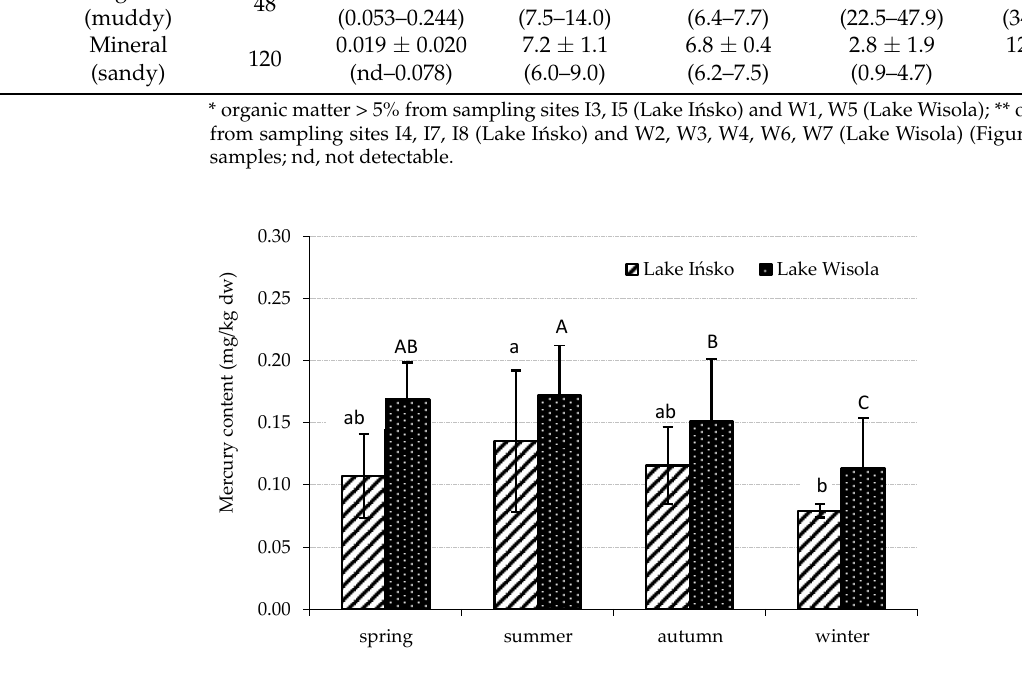
Figure 2. Seasonal variability in mercury content in organic sediments of lakes I ń sko and Wisola. Statistically significant seasonal differences in the content of Hg in the sediments of Lake I ń sko are indicated by different lowercase letters, and in sediments of Lake Wisola by different capital letters (Duncan’s test, p < 0.05).